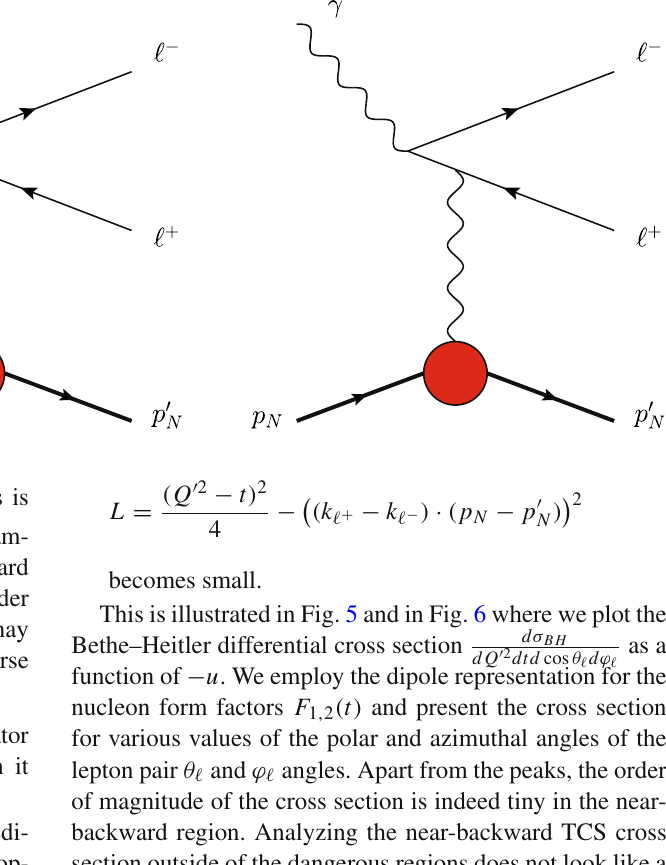
Fig. 3 The kinematical variables and coordinate axes in the γ p CMS. The CMS scattering angle θ ∗ u (10) is defined as the angle between (cid:10) q and (cid:10) p (cid:4) . The boost along the z (cid:4) direction allows to switch to (cid:6) + (cid:6) − - N CMS frame. The azimuthal angle ϕ ∗ is defined as the angle between